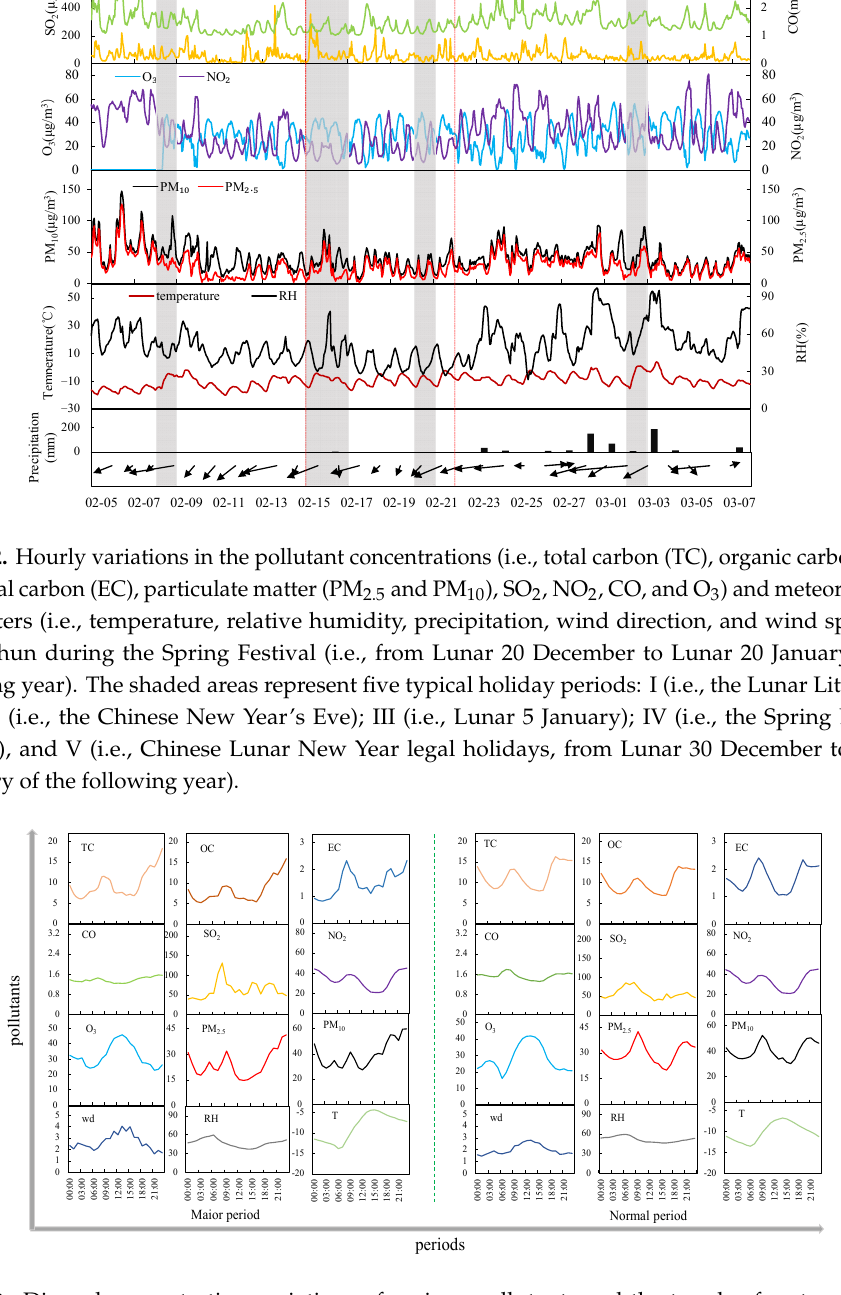
Figure 3. Diurnal concentration variations of various pollutants and the trends of meteorological factors by major and normal period during the Spring Festival in Changchun City, Jilin Province. Note: except for CO, the units of remaining pollutants are µ g / m 3 , while for CO is in mg / m 3 ; the units of wind speed, relative humidity, and ambient temperature are m / s, %, and ◦ C,